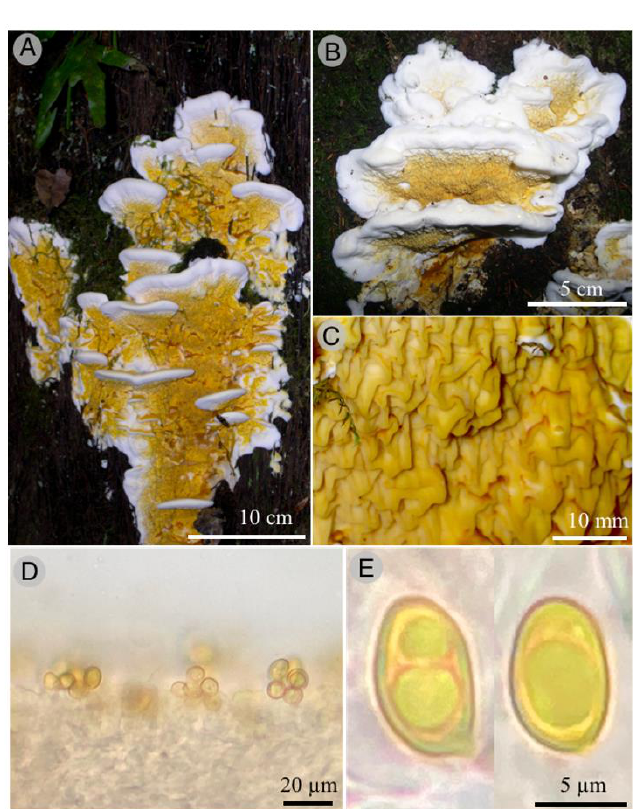
Figure 5. Serpula cyatheicola . ( A , B ): basidiomata; ( C ): detail of hymenophore; ( D ): hymenium; ( E ): optical microscope images of basidiospores.